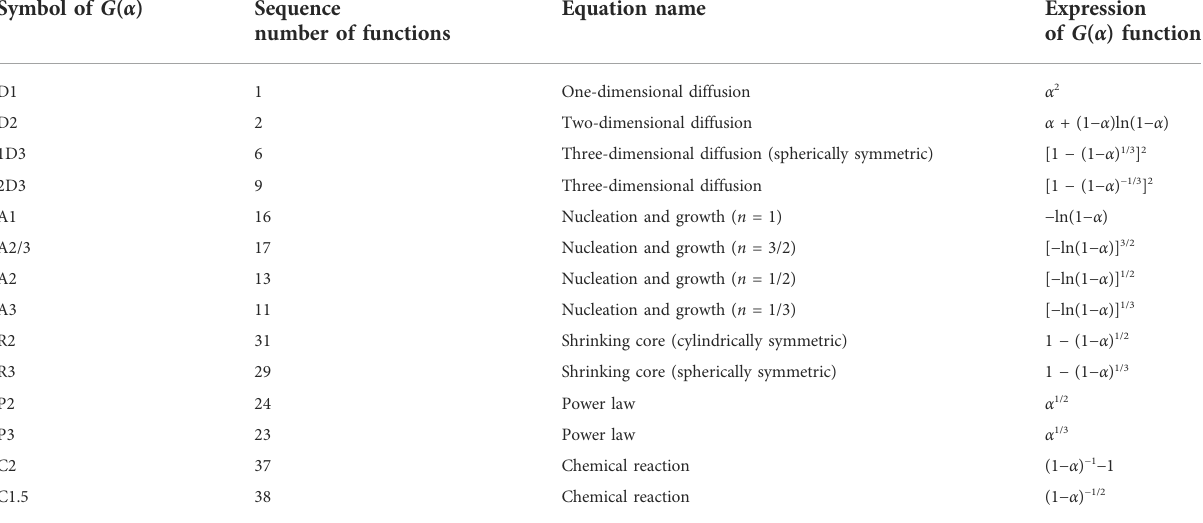
TABLE 2 Common G ( α ) functions for solid-state reactions. Symbol of G ( α )